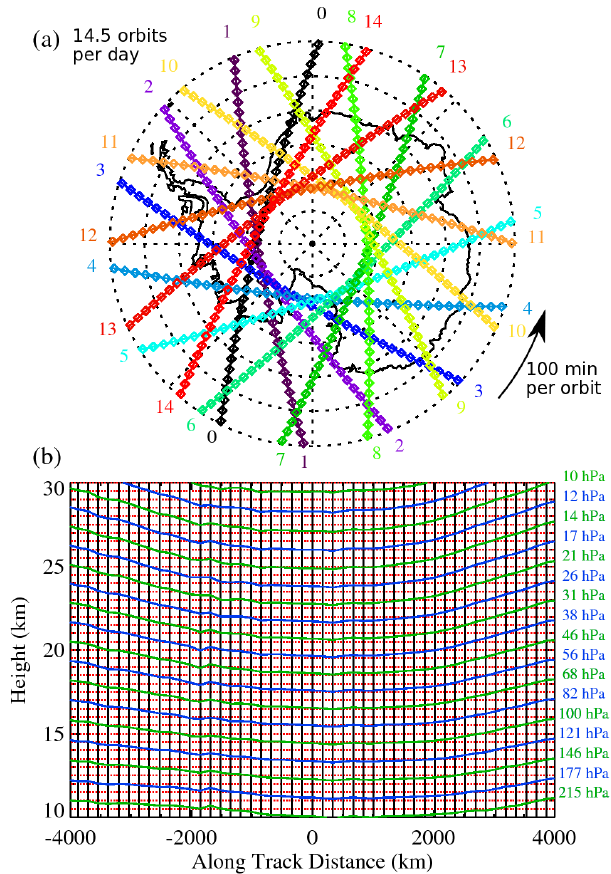
Fig. 1. (a) Example of a complete day of orbit tracks over Antarc- tica, with different colors identifying each orbit. The along-track colocation origin is defined as the closest approach of the orbit track to the South Pole. The satellites cover a distance of 1800km in 4min, and during this time MLS makes 11 limb scans and CALIOP fires 4800 laser shots. (b) Height vs. along-track data analysis grid (red dots) with corresponding pressure levels indicated on the right vertical axis. The horizontal and vertical spacings are 50km and 0.5km, respectively. The majority of the MLS species, includ- ing HNO 3 , are retrieved at a lower vertical resolution (6 levels per decade in pressure, green lines) than are temperature, H 2 O and O 3 (12 levels per decade, blue and green